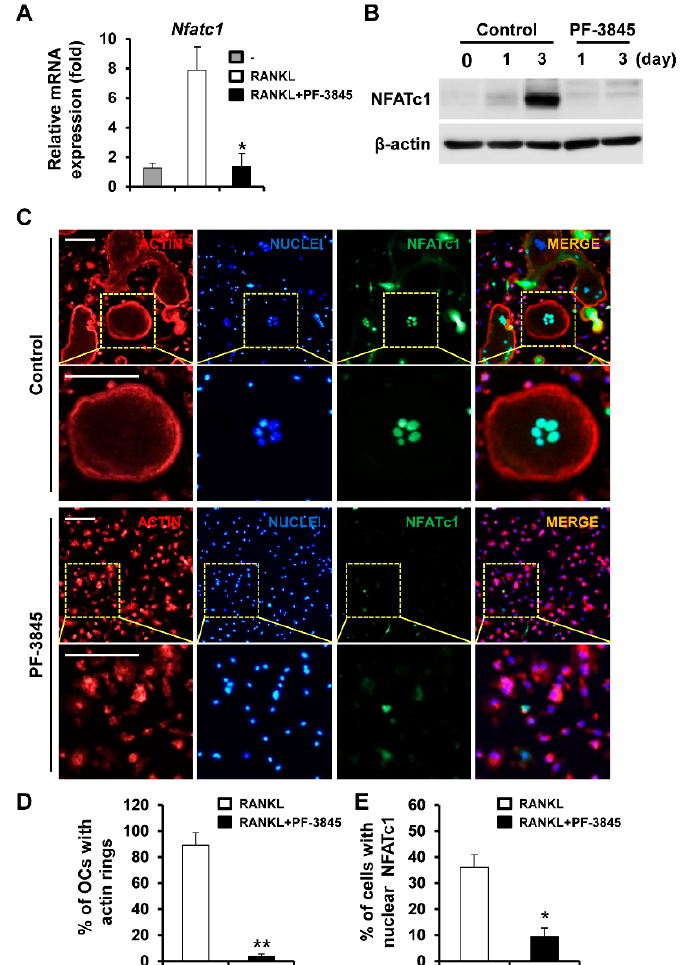
Figure 2. The effect of PF-3845 on nuclear factor of activated T-cells cytoplasmic 1 (NFATc1) expression and actin ring formation. BMMs were cultured in an osteoclastogenic medium with the vehicle or 10 µ M PF-3845 for four days ( A , C – E ) or the number of days indicated ( B ). The mRNA ( A ) and protein ( B ) expression of NFATc1 were examined. ( C ) After four days of culture, the cells were probed with anti-NFATc1 antibody followed by staining with rhodamine-conjugated phalloidin and 4 ′ ,6-diamidino-2-phenylindole dihydrochloride (DAPI) to visualize F-actin and nuclei, respectively. The percentage of ( D ) osteoclasts with actin rings and ( E ) nuclear NFATc1-positive cells was assessed. Yellow dashed box: magnified region, scale bar, 50 µ m. * p < 0.05, ** p < 0.01 (two-tailed Student’s t -test).